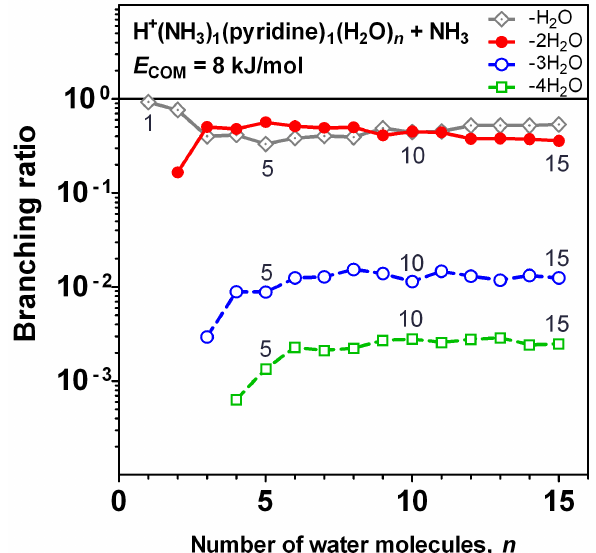
Fig. 5. Branching ratios for H + (NH 3 ) 1 (pyridine) 1 (H 2 O) n reacting with NH 3 at E COM = 8kJmol − 1 . The curves represent peaks cor- responding to the parent ion incorporating NH 3 and losing one to four H 2 O. Dashed lines indicate products likely resulting from clus- ters that have lost water molecules prior to reaction. The numbers next to the curves indicate the number of water molecules, n